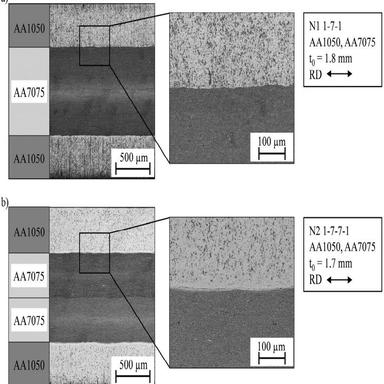
Micrograph of the multilayered material a) after one rolling cycle N1 1-7-1 and b) after two rolling cycles N2 1-7-7-1.